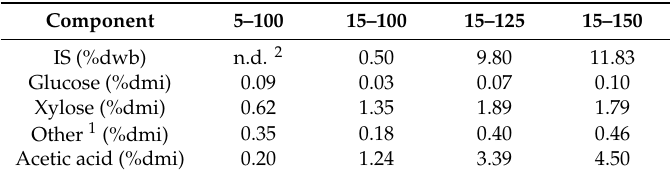
Table 4. Liquid fraction composition in terms of insoluble solids (IS) per weight of filtrate, sugar content (in both monomeric and oligomeric form) per weight of dry matter inlet (dmi) and acetic acid per dry weight matter